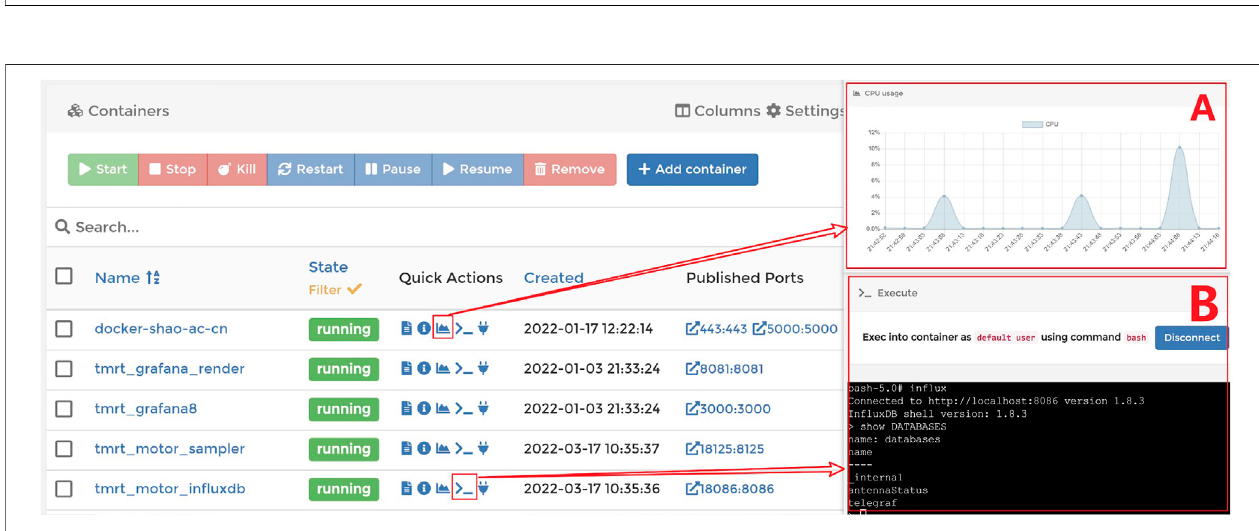
FIGURE 7 | This is an example of using the Portainer to manage the TAEWS system. The information of all the services, such as current running status, creation time, and port occupancy, is clearly visible on the page, and operations such as logging, terminal, and status view are available in the Quick Actions column.